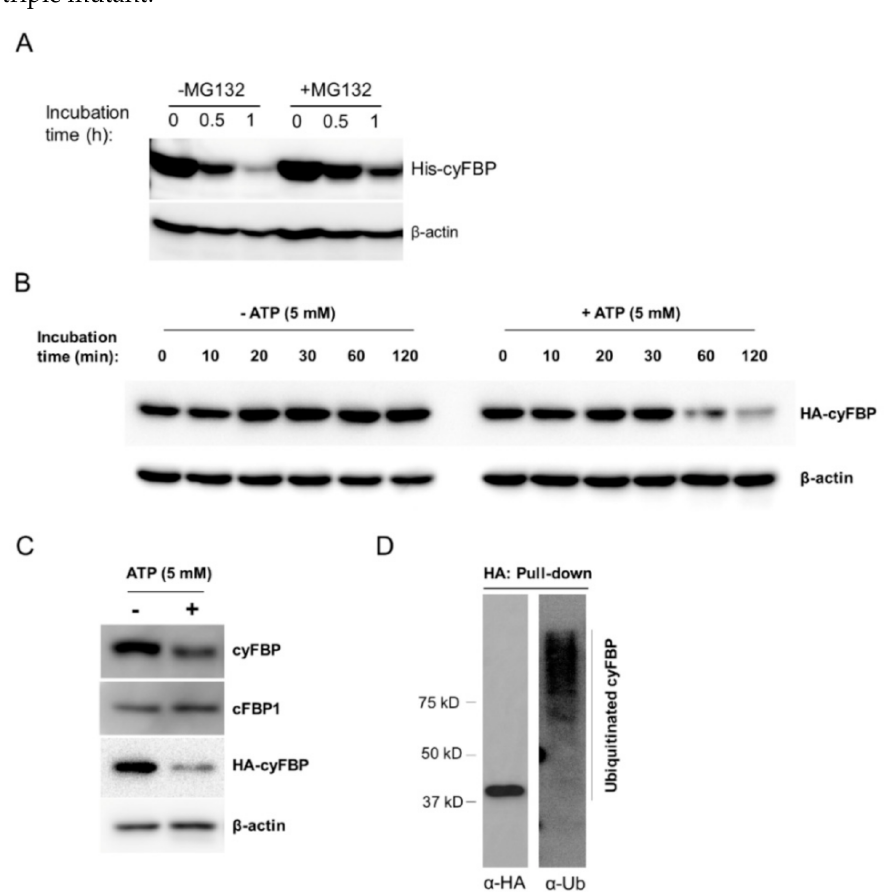
Figure 4. Analysis of cyFBP protein degradation. ( A ) MG132 inhibits the degradation of His-cyFBP in the plant protein extract. The total protein extract was prepared from mature leaf tissues of 6-week- old WT plants. Recombinant His-cyFBP protein (300 ng) was added to the total protein extract (500 µ g) in 100 µ L of reaction volume with or without MG132 (100 µ M). His-cyFBP protein was detected by Western blotting using an anti-His-tag antibody. β -actin was used as a loading control for the total protein extract added. ( B ) Effect of ATP on HA-cyFBP degradation by an in vitro assay. The total protein extract was prepared from the transgenic p35S::HA-cyFBP plants. About 60 µ g of total proteins in 50 µ L of reaction volume were incubated at room temperature (21 ◦ C) with or without (5 mM) ATP for the indicated lengths of time (min). The samples were added with 4X SDS loading buffer to stop the reaction and then used in Western blotting with an anti-HA antibody to detect the HA-cyFBP protein. β -actin protein was detected as a loading control. ( C ) Effect of ATP on the degradation of cyFBP and cFBP1. Total proteins from transgenic p35S::HA-cyFBP plants (T3 line) were isolated and incubated with or without (5 mM) ATP for 2 h. cyFBP and cFBP1 proteins were detected using Western blotting with anti-cyFBP and anti-cFBP1 antibodies. The HA-cyFBP was also analyzed as a positive control. β -actin protein was detected as a loading control. ( D ) Detection of HA-cyFBP ubiquitination. Total proteins were extracted from 2-week-old seedlings. The HA-cyFBP protein was pulled down from the total proteins (1 mg) using HA-agarose beads and analyzed by western blotting. The left panel shows the immunoblot with an anti-HA antibody and the right panel shows the blot with an anti-Ub